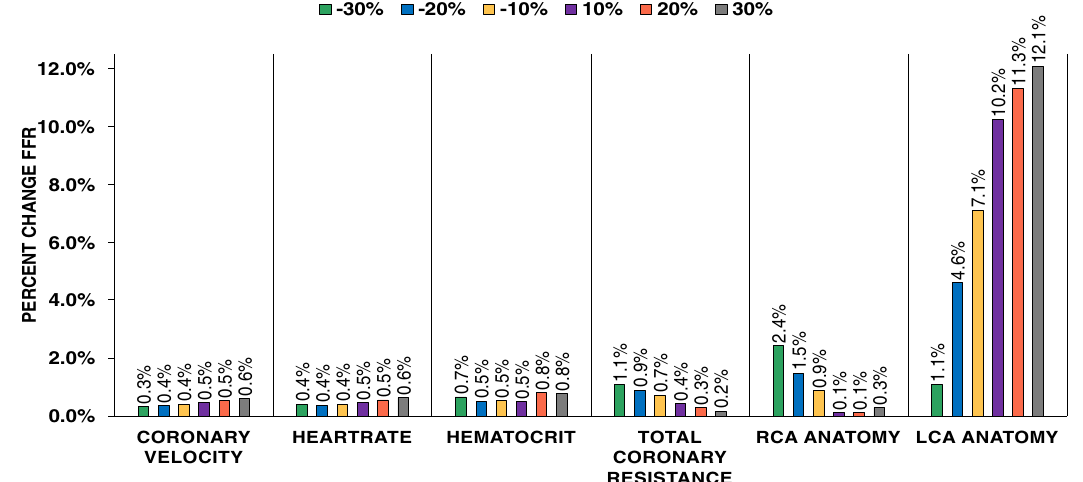
Figure 7. Sensitivity analysis. Coronary anatomy is the driving feature for FFR predictions. Key hemodynamic input parameters: coronary velocity, heartrate, hematocrit and resistance were varied by ±10%, ±20%, and ±30%. To account for geometric influence percent stenosis was varied by ±10%, ±20%, and